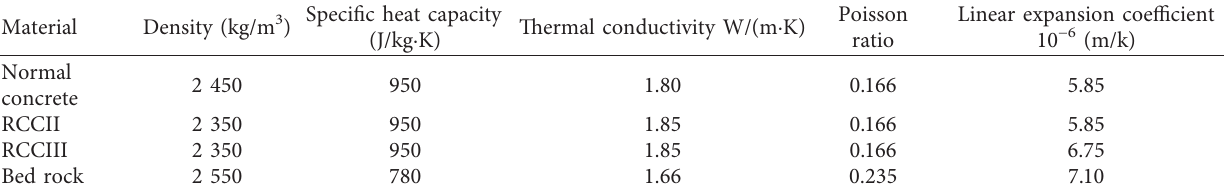
Figure 2: Finite element model. Table 2: Material parameters.